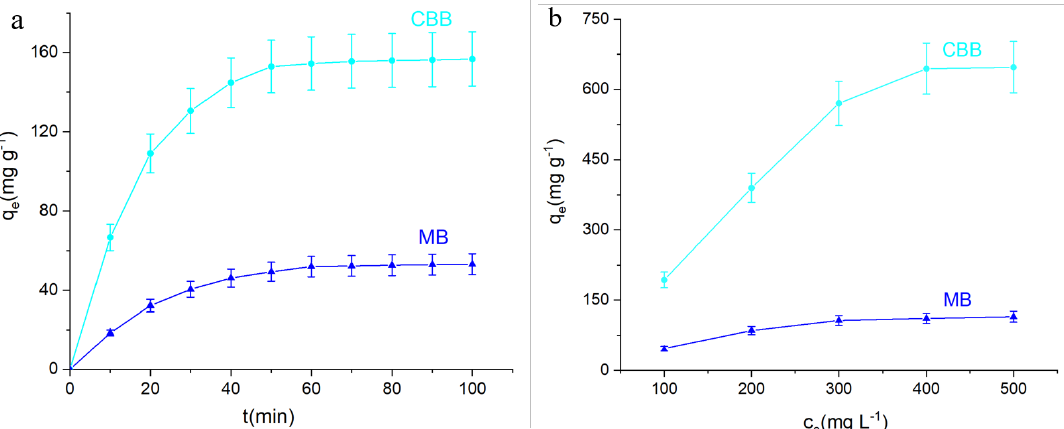
Figure 5. ( a ) Time adsorption curves of A-4 on CBB and MB (adsorbent 5 mg, dye concentration 100 mg L − 1 , room temperature). ( b ) The maximum adsorption capacity of A-4 for CBB and MB at different initial concentrations. The adsorption time was over 24 h.